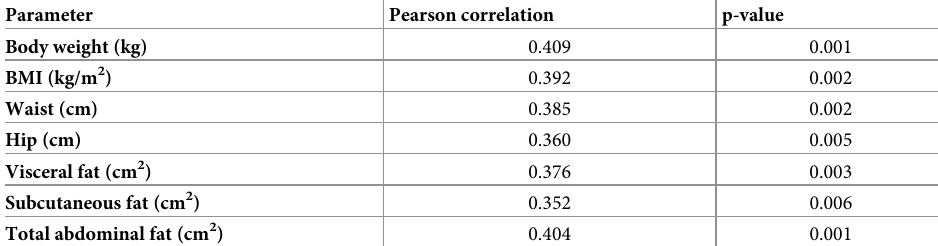
Table 3. Significant correlations between serum PRCP activity in overweight/obese patients (n = 60) and several metabolic parameters.